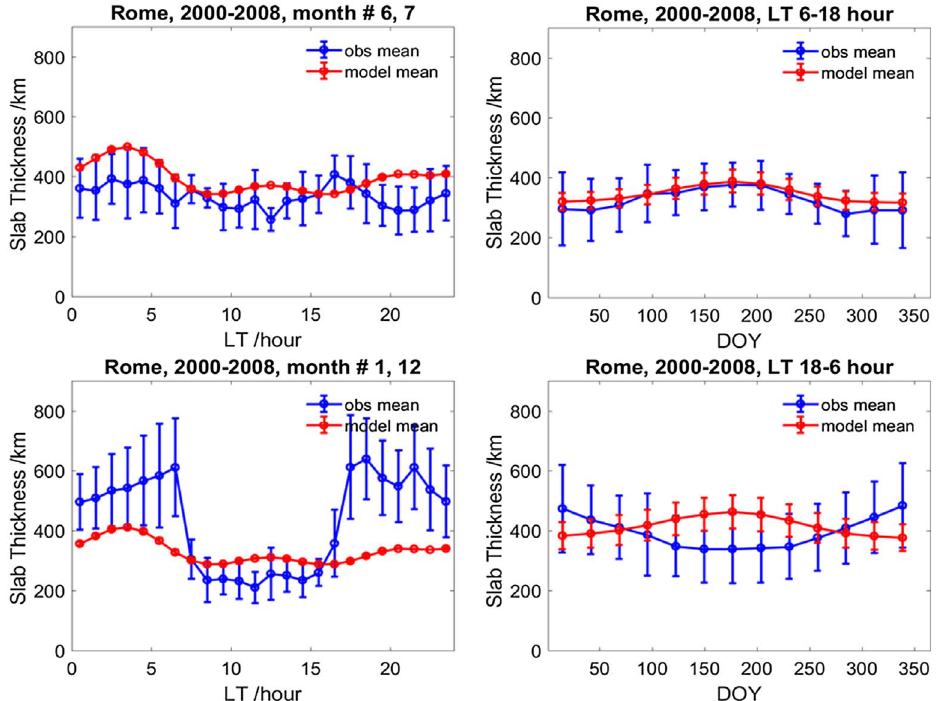
Fig. 11. Diurnal and seasonal variation of the observed and modelled s over Rome for summer (June/July) and winter (December/January) conditions and for day (6 – 18 LT) and nighttime (18 – 6 LT) conditions,